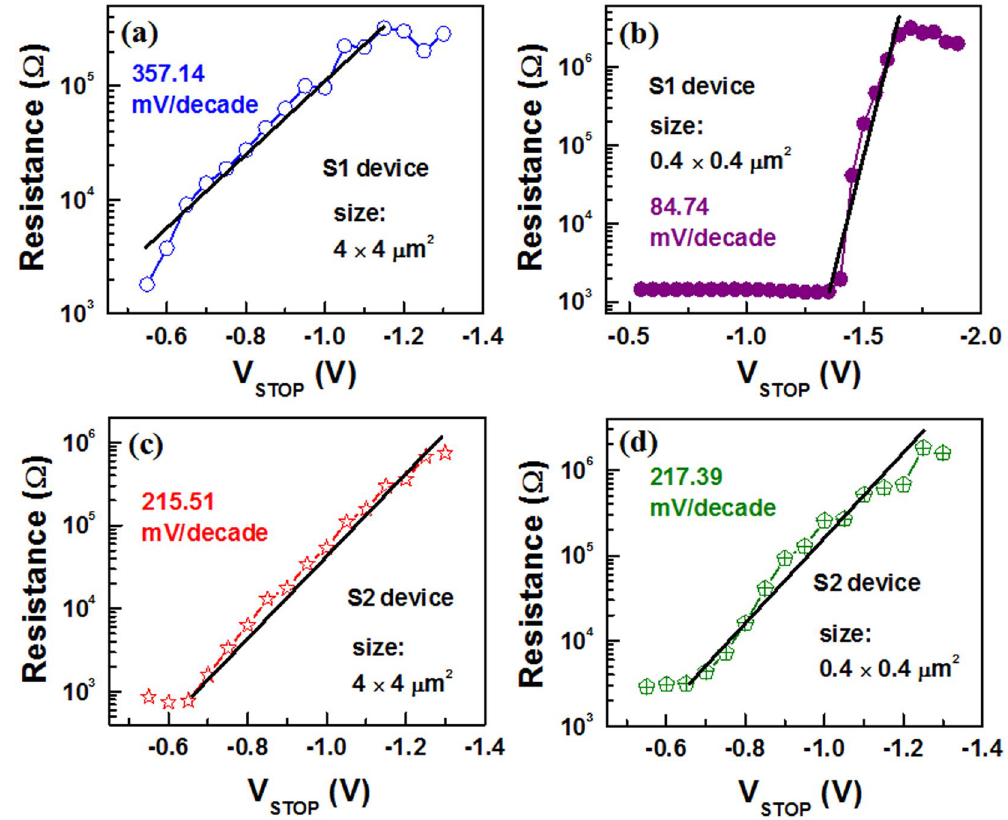
Figure 7. Variation of HRS with negative stop voltage of the S1 devices with ( a ) 4 × 4 µ m 2 and ( b ) 0.4 × 0.4 µ m 2 . The S2 devices with ( c ) 4 × 4 µ m 2 and ( d ) 0.4 × 0.4 µ m 2